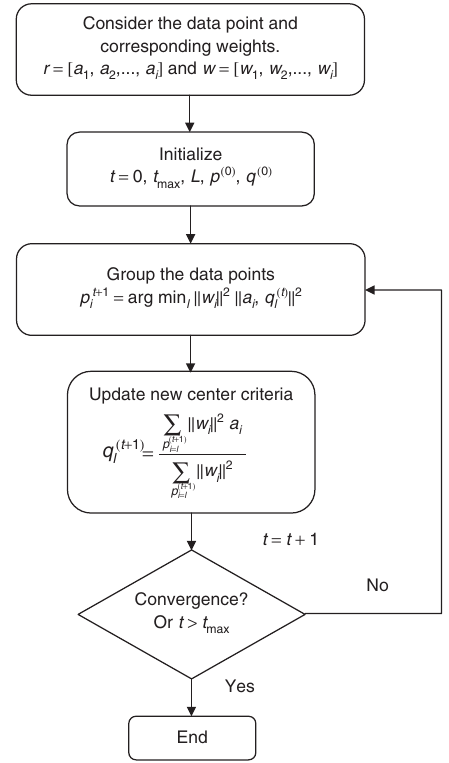
Figure 3: Flow Diagram of the Proposed WKMC